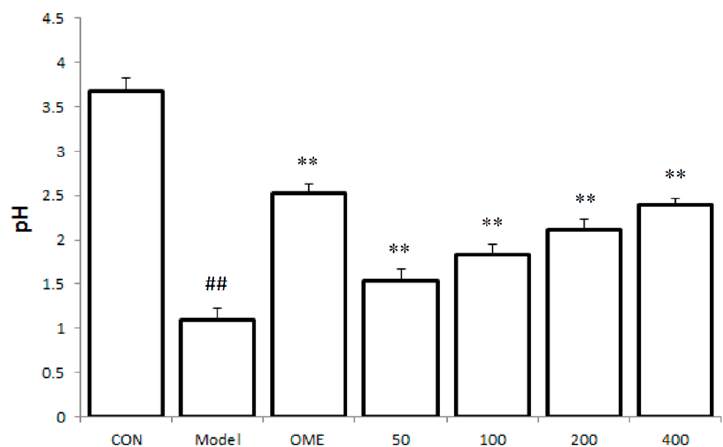
Figure 2. Effect of LCA on gastric juice acid content (pH). Data are expressed as the mean ± SD ( n = 8). ##: p < 0.01 vs. control group. **: p < 0.01 vs. model group. (CON = control; OME = omeprazole).